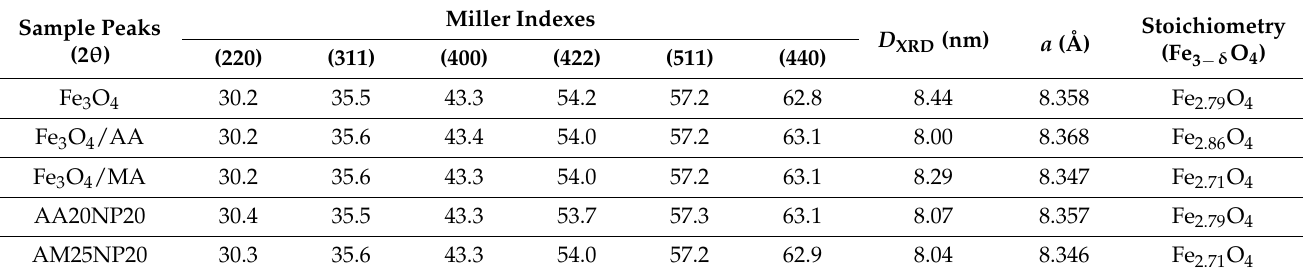
Table 2. Characteristic peaks along with Miller indexes, crystallite size, lattice parameter, and stoichiometry of pure and modified Fe 3 O 4 magnetic nanoparticles and magnetic poly(vinyl pivalate)